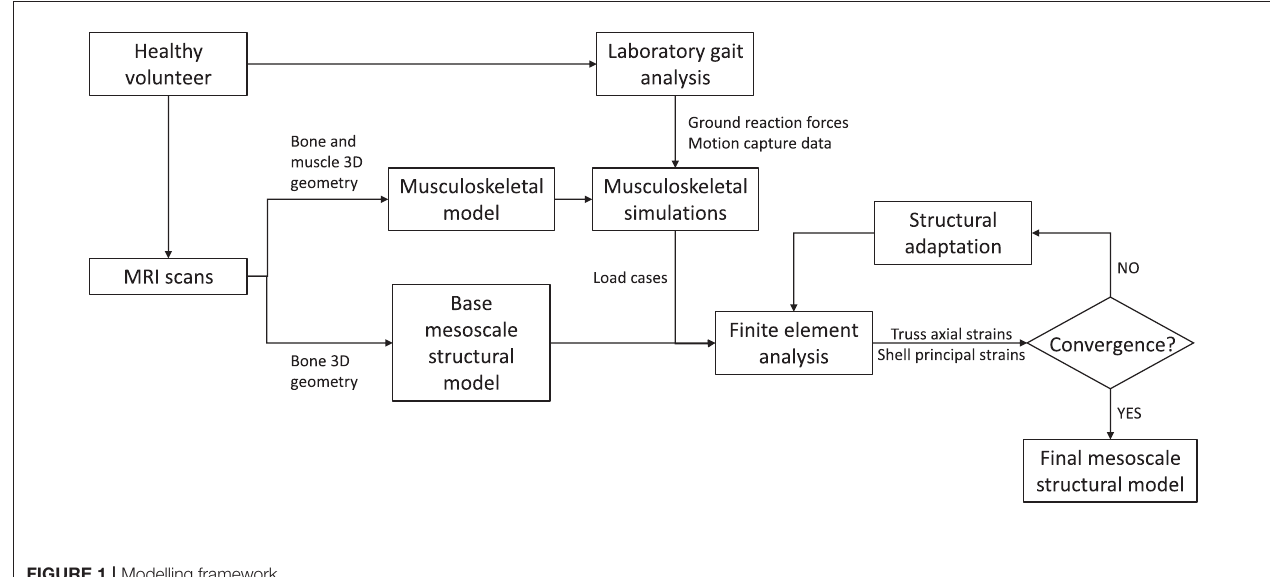
FIGURE 1 | Modelling